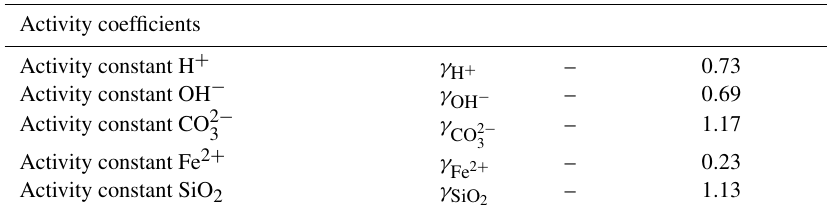
Kinetic exponent greenalite precipitation b greenalite Activity coefficients Activity constant H + γ H +